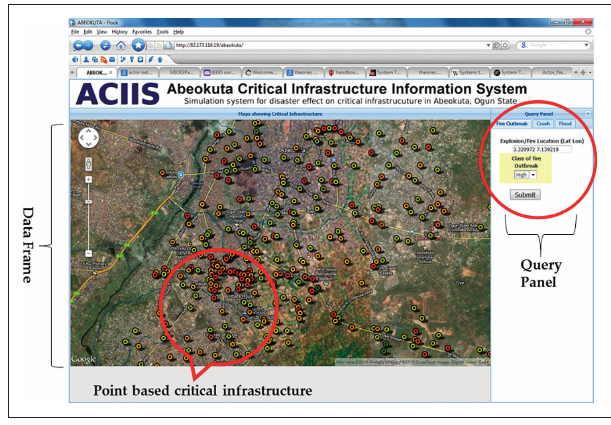
FIGURE 6: Abeokuta Critical Infrastructure Information System (ACIIS) interface showing the data frame and the Query Panel.